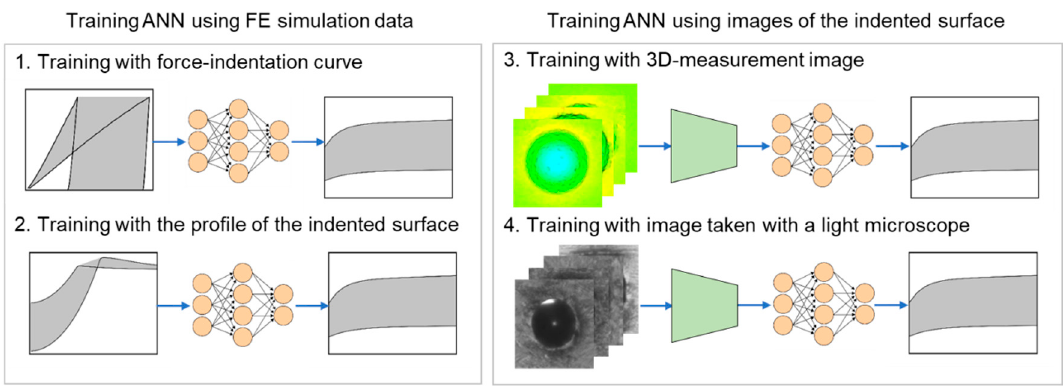
Figure 1. General workflow of the ANN training with the four different types of database.